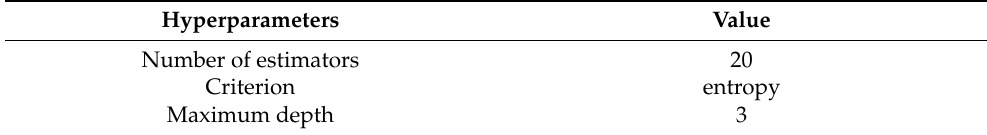
Table 4. Proposed random forest model hyperparameter